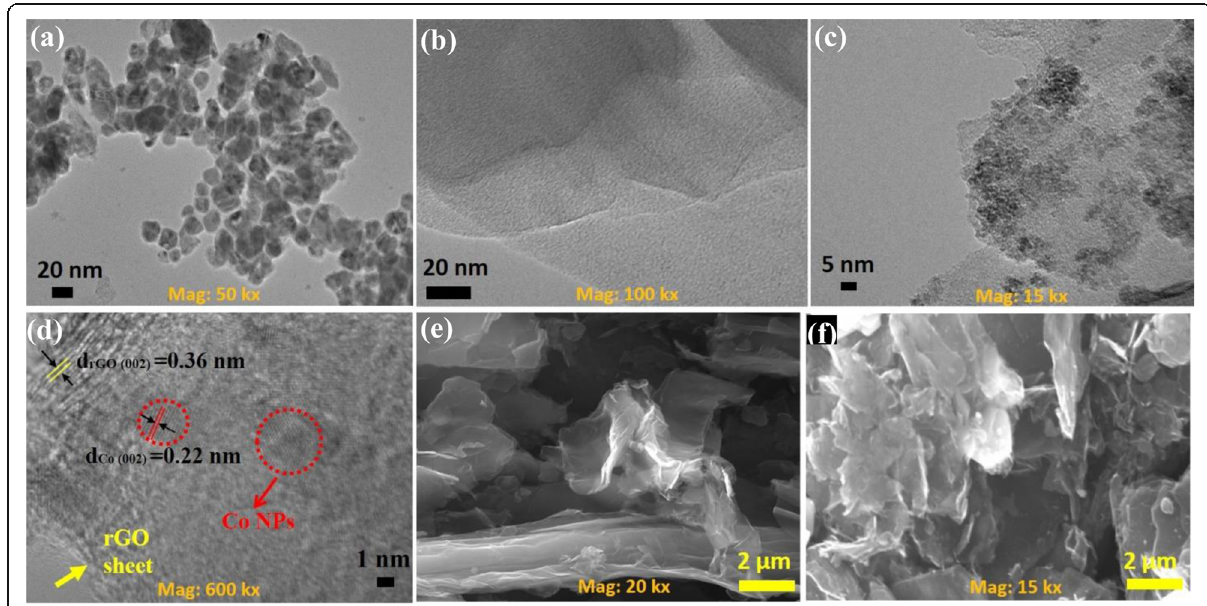
Fig. 2 a – d TEM images a Co NPs, b rGO nanosheets, c and d Co-rGO nanohybrid. e – f SEM images e rGO nanosheets and f Co-rGO